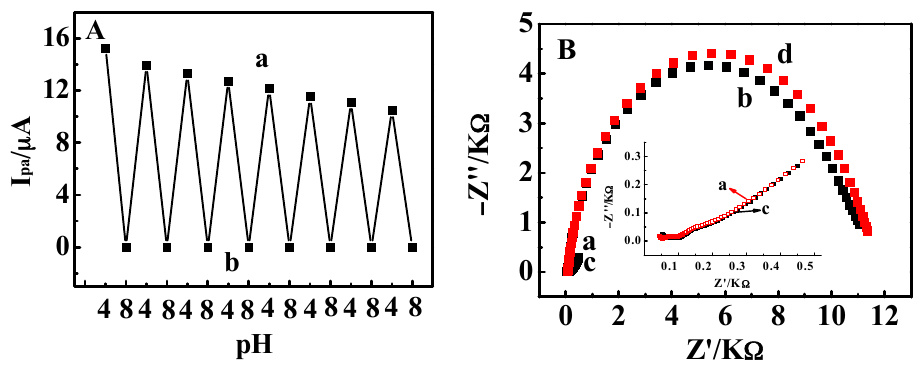
Figure 4. ( A ) Dependence of CV oxidation peak current (I pa ) of Fc(COOH) 2 at 0.1 V·s − 1 on solution pH switched between pH 4.0 and 8.0 for the same {Con A/GOD} 5 films; ( B ) EIS responses of 10 mM Fe(CN) 63 − /4 − at 0.17 V on solution pH switched between ( a ) pH 4.0, ( b ) 8.0 of the first cycle, ( c ) pH 4.0 and ( d ) 8.0 of the second cycle for {Con A/GOD} 5 films. Inset is a magnification of curve a and curve c.